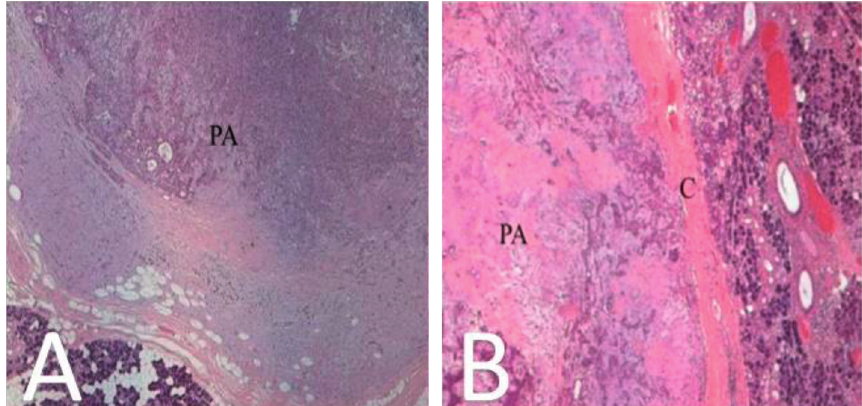
Figure 3: Histological view of pleomorphic adenoma of the parotid gland (a) and of the submandibular gland (b). PA � pleomorphic adenoma; C �